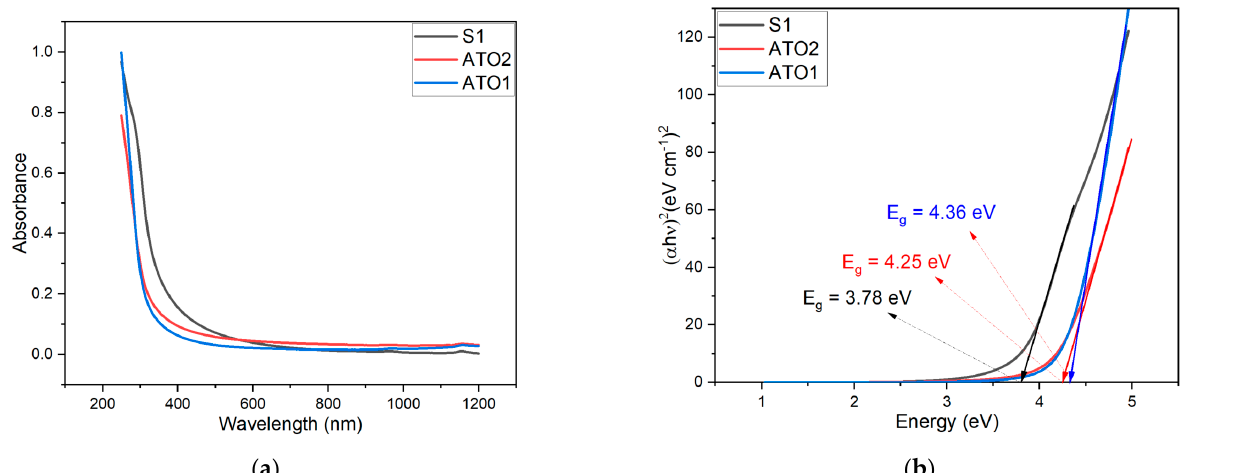
Figure 5. ( a ) UV-visible spectra of the S1, ATO1, and ATO2 powders; ( b ) Tauc plots obtained by the UV-visible spectra for the direct band-gap calculation.